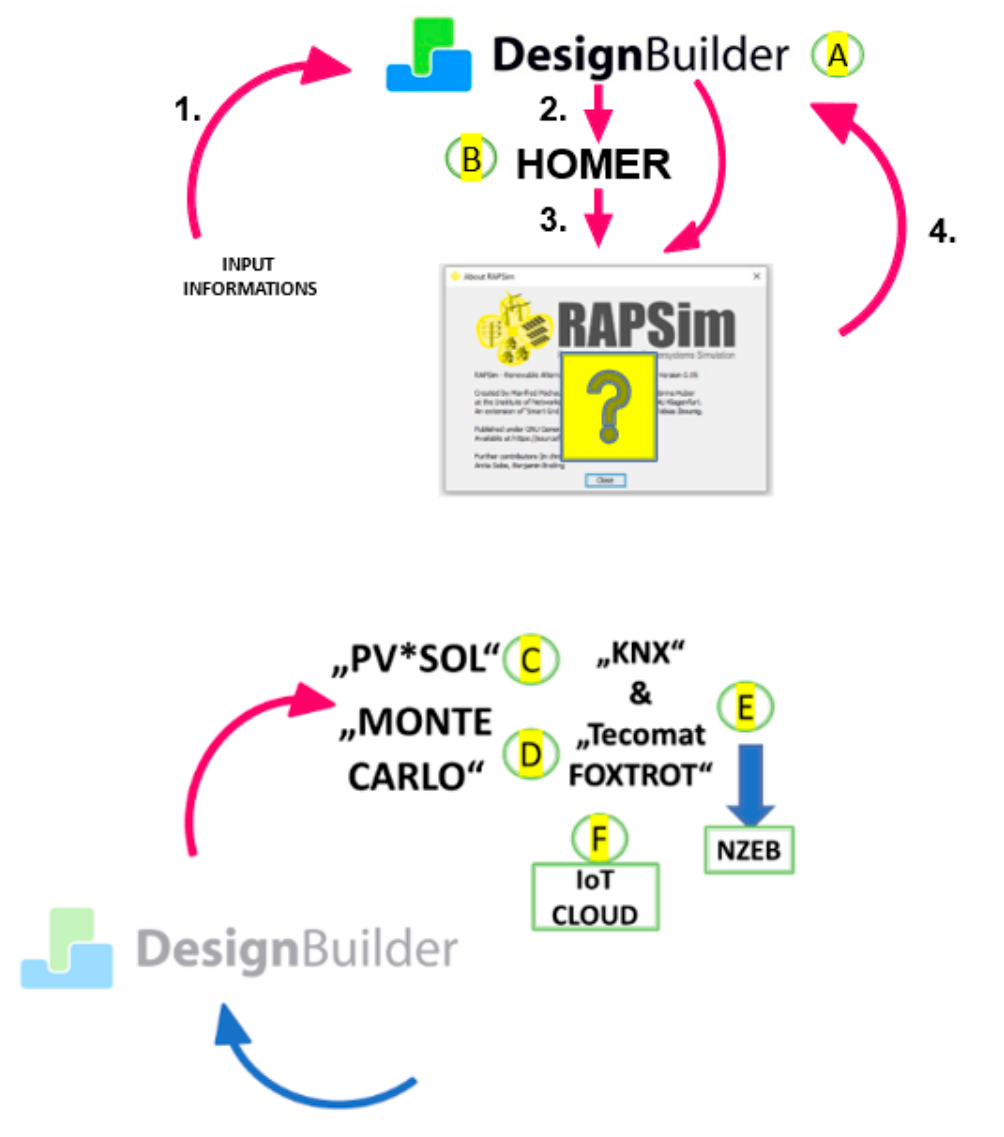
Figure 6. EPB Solution Principle as a Unified SES.